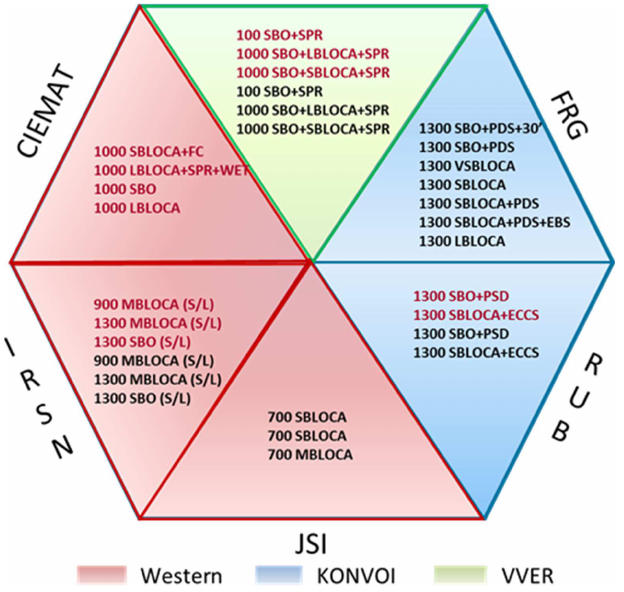
Fig. 9. Severe accidents sequences